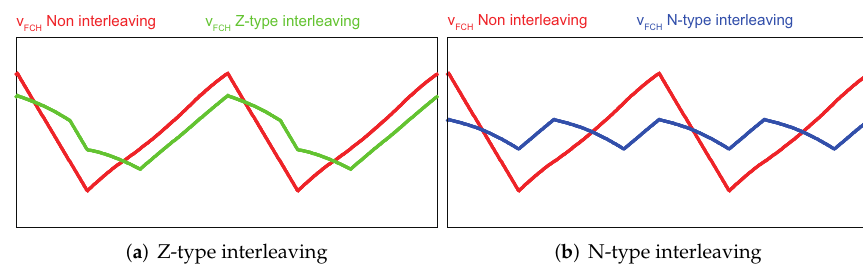
Figure 11. High-side capacitor voltage waveforms.